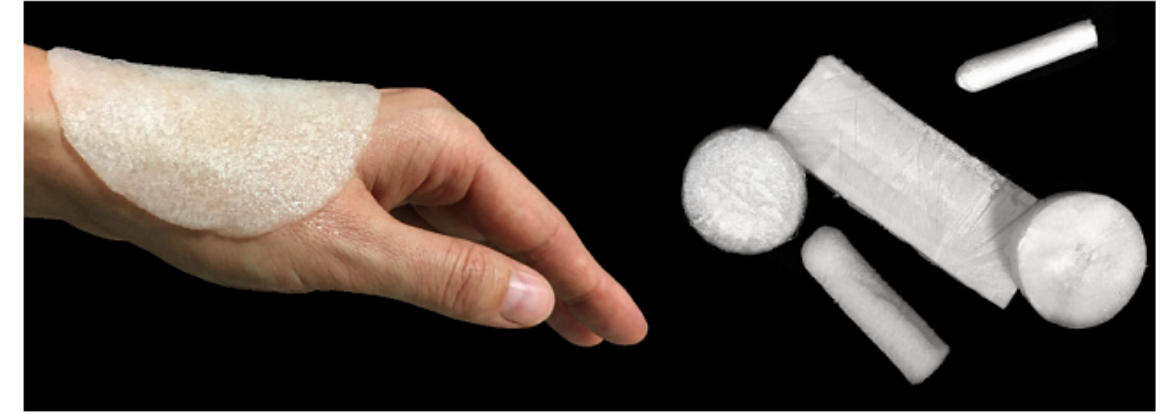
Figure 4. Agarose/curd dressing materials such as foam in different shapes and sizes according to the Polish patent number PL 236,367 [57].